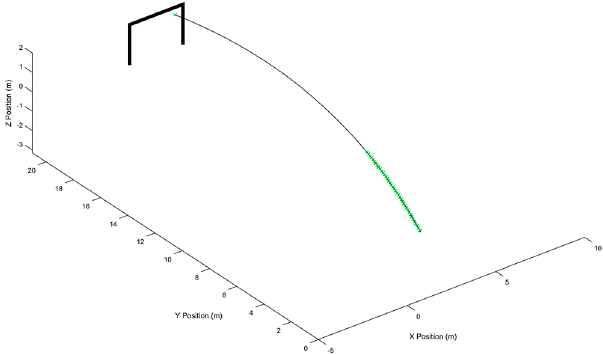
Figure 1. Three-dimensional trajectory of U16 academy player free kick (adapted from Choppin